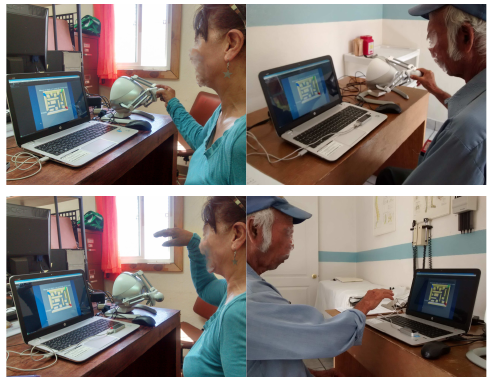
Fig. 2. Participants conducting the exercise with the Novint Falcon haptic device (above) and the Leap Motion device (below): adult with no motor impairment (left) and elder with motor impairment (right).